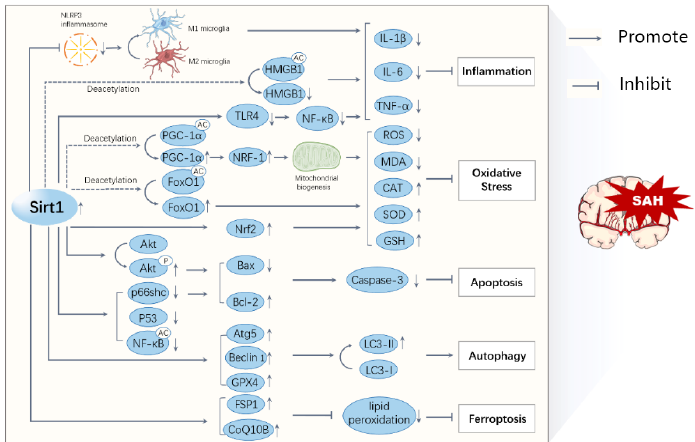
Figure 2. A schematic diagram illustrating the major mechanisms of Sirt1 in SAHs. The activation of Sirt1 reduces the acetylation and activation of transcription factors, such as HMGB1, PGC-1 α , FoxO1, and NF-kB, leading to decreased inflammation, oxidative stress, apoptosis, ferroptosis, and increased autophagy. All these processes interact with each other and contribute to the progression of a SAH.